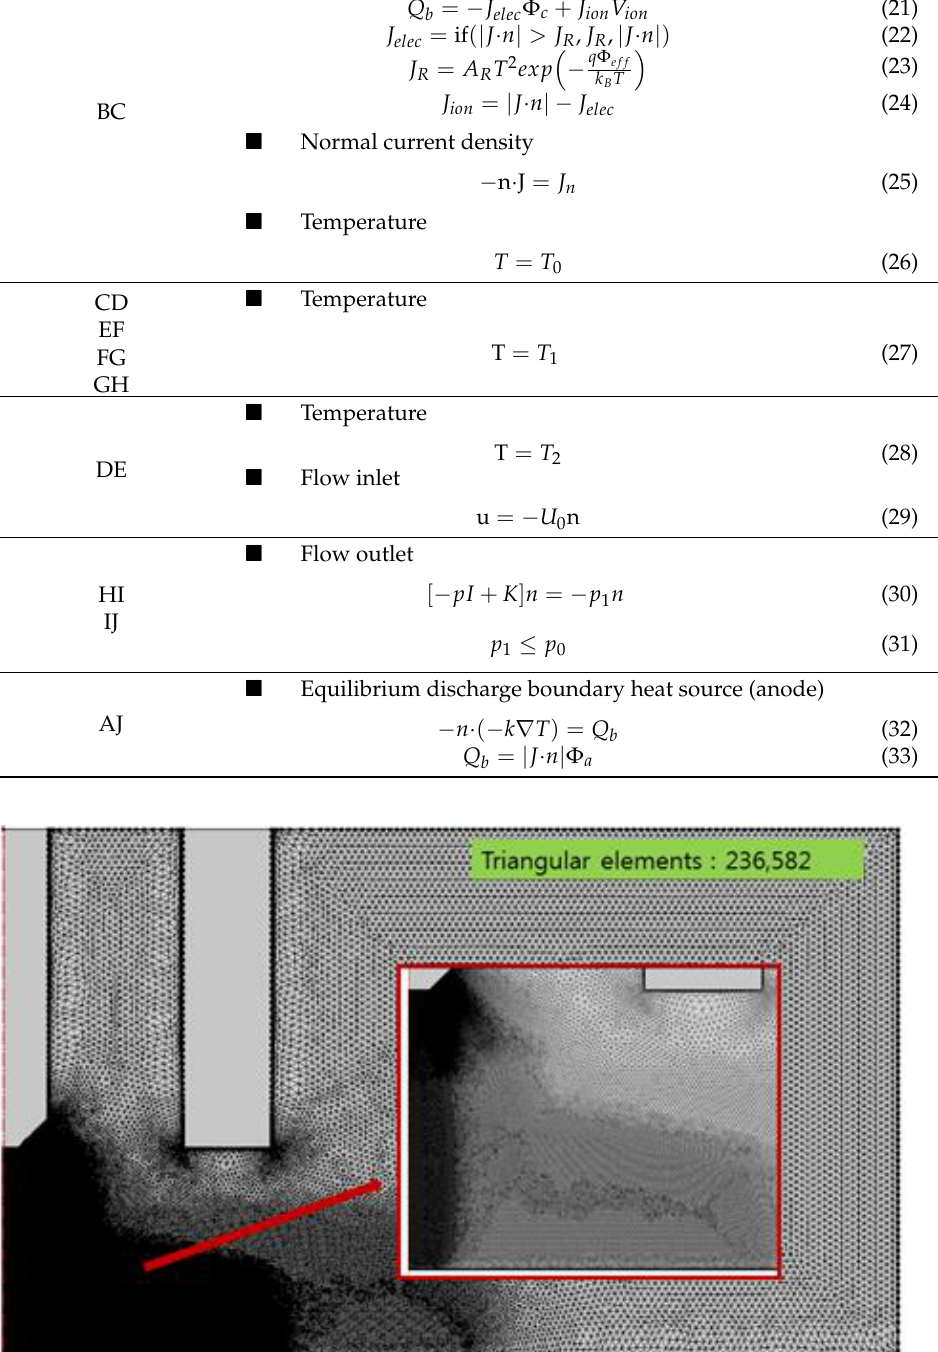
Figure 2. Application of mesh in arc plasma area.